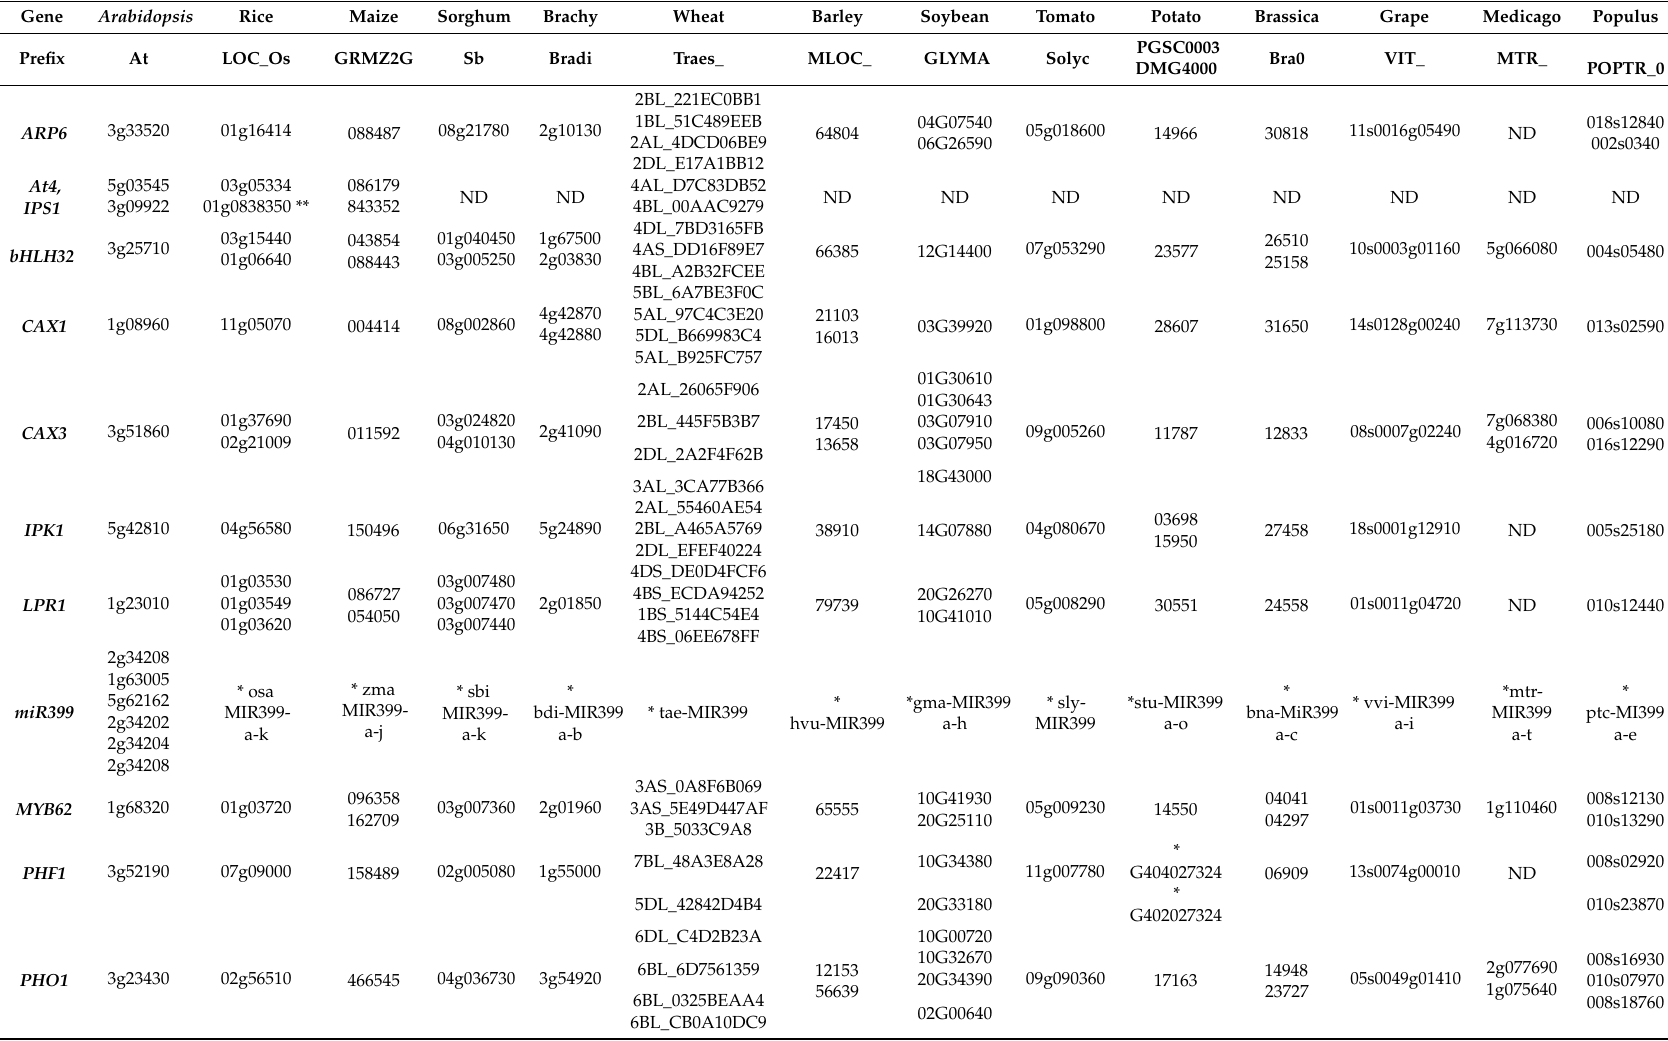
Table 2. Phosphate Starvation-Induced genes in Arabidopsis and their respective orthologs in different crop